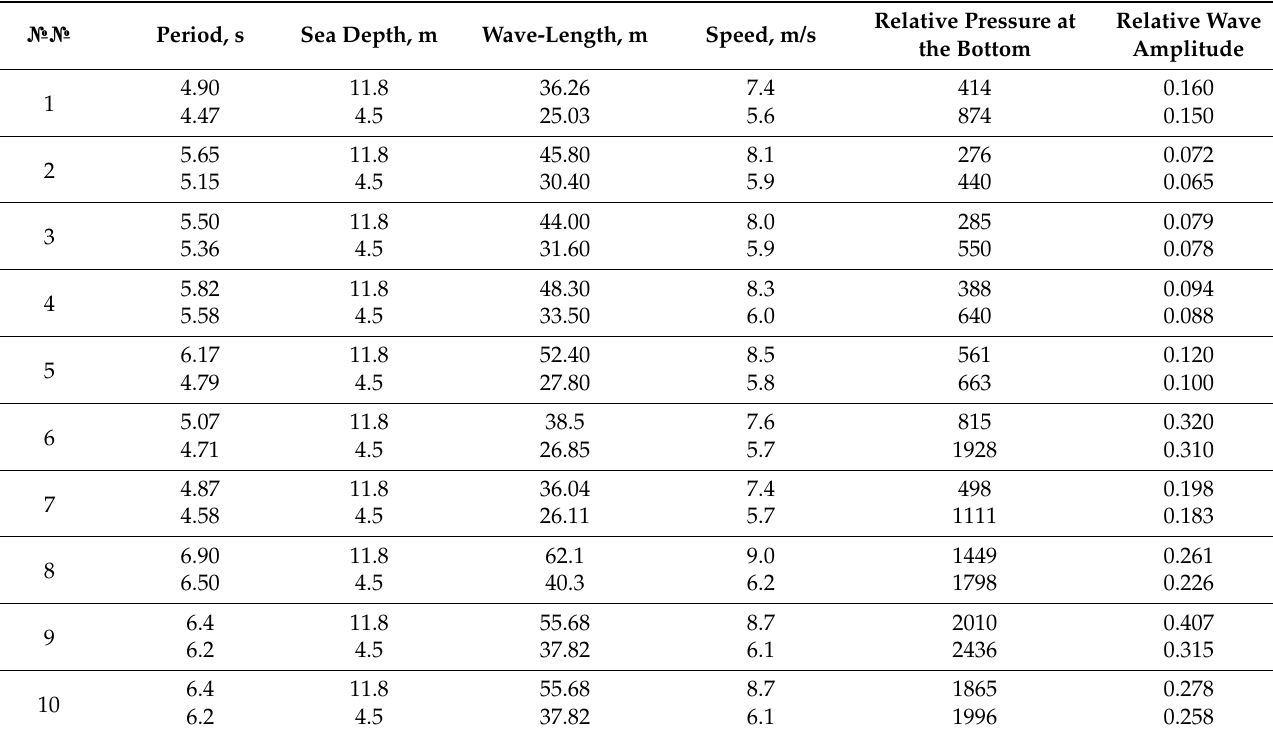
Table 1. Experimental